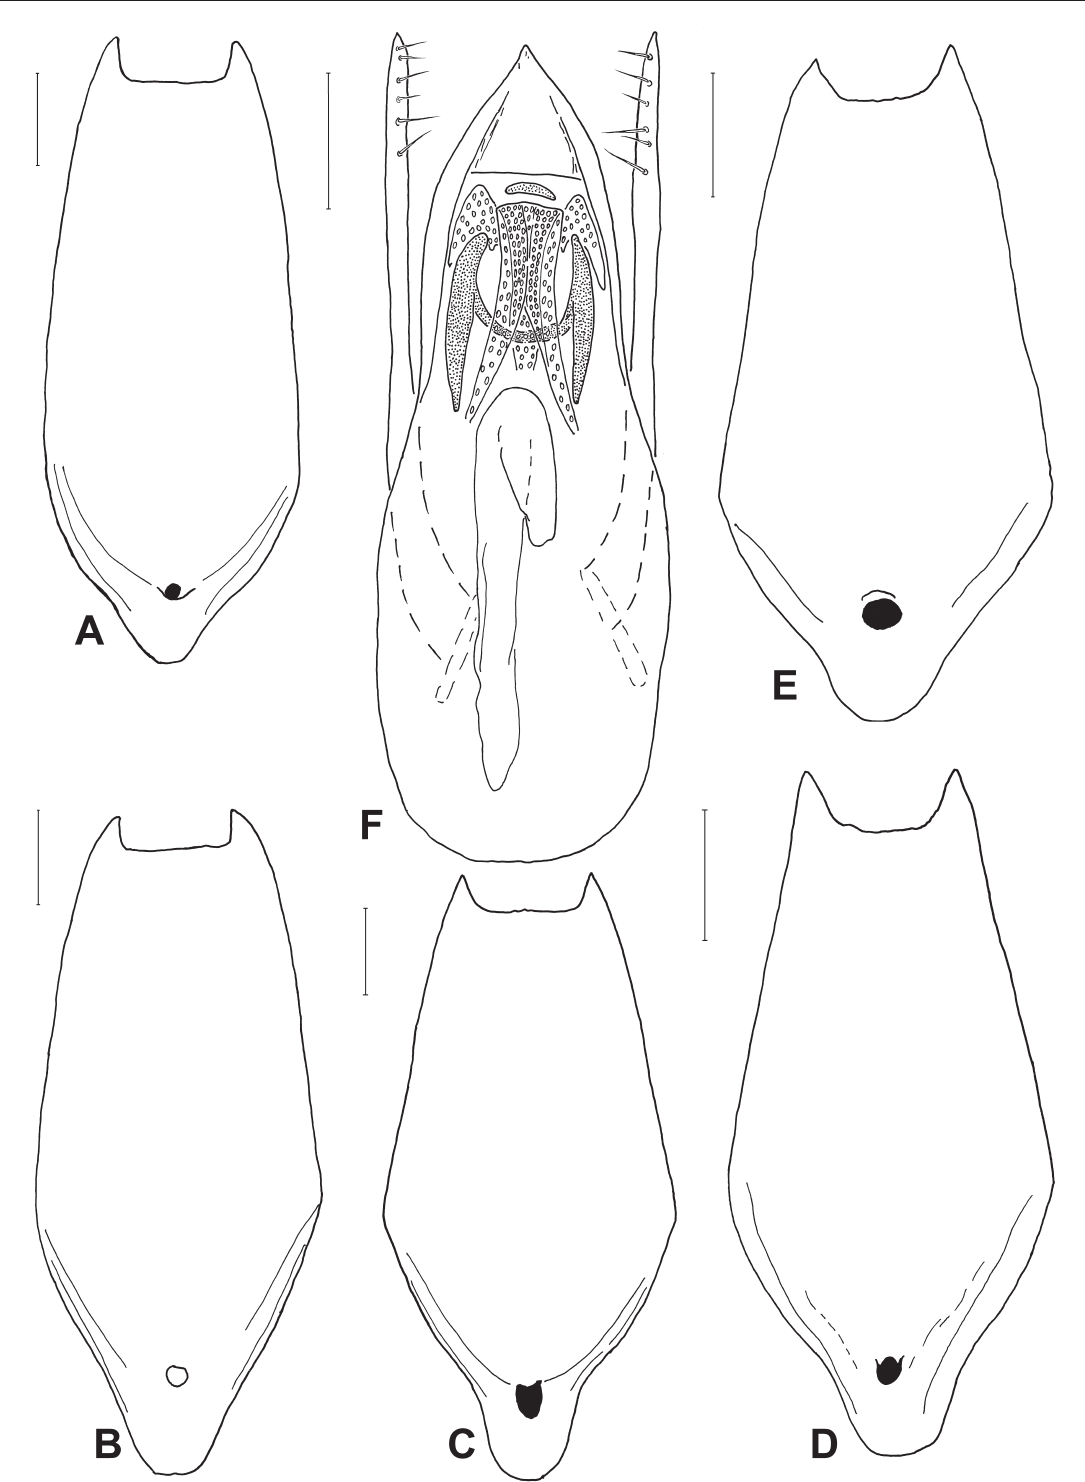
Fig. 5. ♂ copulative structures. A–E : Abdominal sternite 9. A . Stenus ( Nestus ) latipennis J. Sahlberg, 1880 (Russia: krasnoyarsk Territory: Mirnoye). B . S. ( N. ) illusor Ryvkin, 1987 (Russia: Magadan Area: 2 km W of Splavnaya). C . S. ( N. ) delitor sp. nov. (holotype). D . S. ( N. ) canosus sp. nov. (holotype). E . S. ( N. ) canalis sp. nov. (holotype). F . S. ( N. ) caseyi Puthz, 1972 (U.S.A.: Michigan: Berrien Co.). Aedeagus, ventral view. – Scales = 0.1